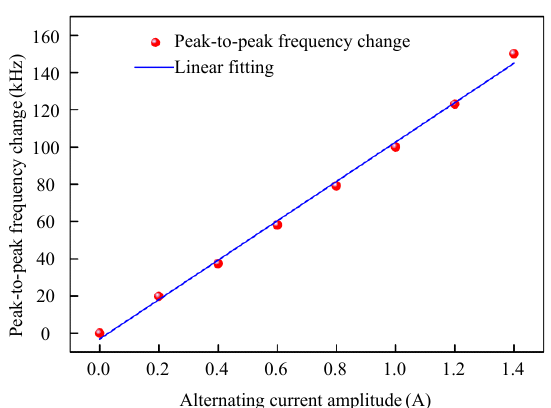
Fig. 4 Beat frequency variation amplitudes for various alternative current amplitudes. The current is alternating at 12 kHz and the magnetic flux density is 3